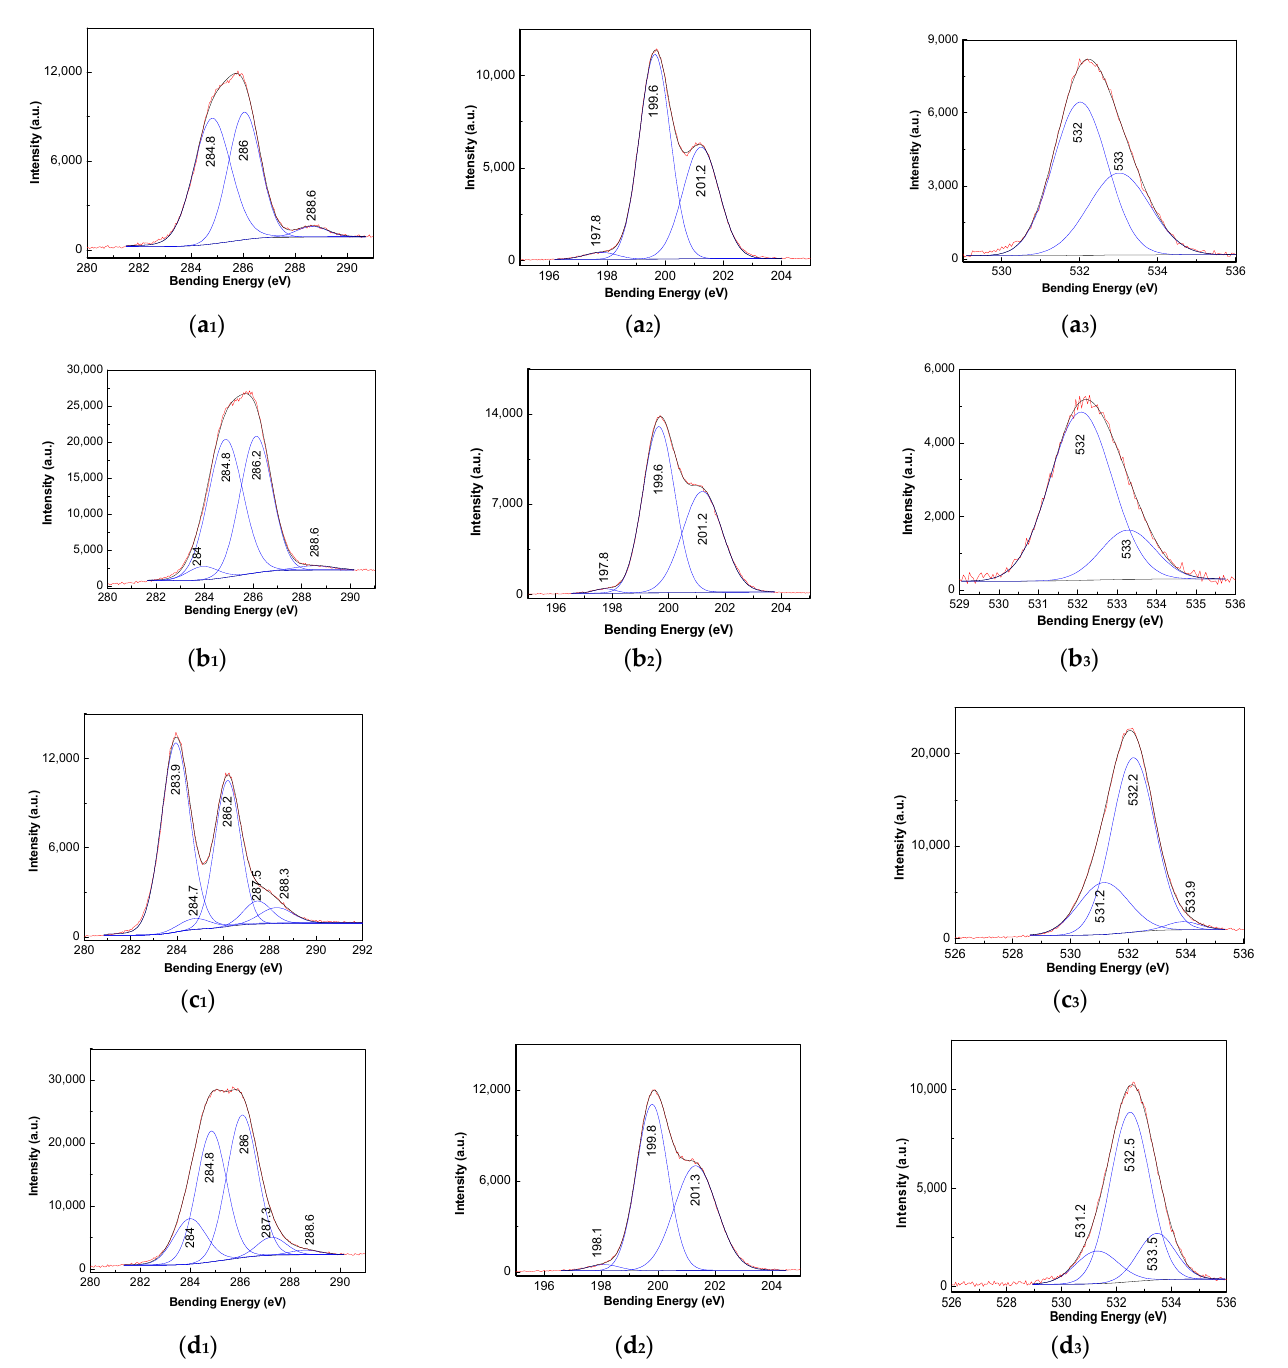
Figure 5. X-ray photoelectron spectroscopy ( XPS) C1s spectra of PVC grains ( a 1 ), PVC spheres ( b 1 ), GO sheets ( c 1 ), and PVC spheres coated with GO sheets ( d 1 ). XPS Cl2p spectra of PVC grains ( a 2 ), PVC spheres, ( b 2 ) and PVC spheres coated with GO sheets ( d 2 ). XPS O1s spectrum of PVC grains ( a 3 ), PVC spheres ( b 3 ), GO sheets ( c 3 ), and PVC spheres coated with GO sheets ( d 3 ).